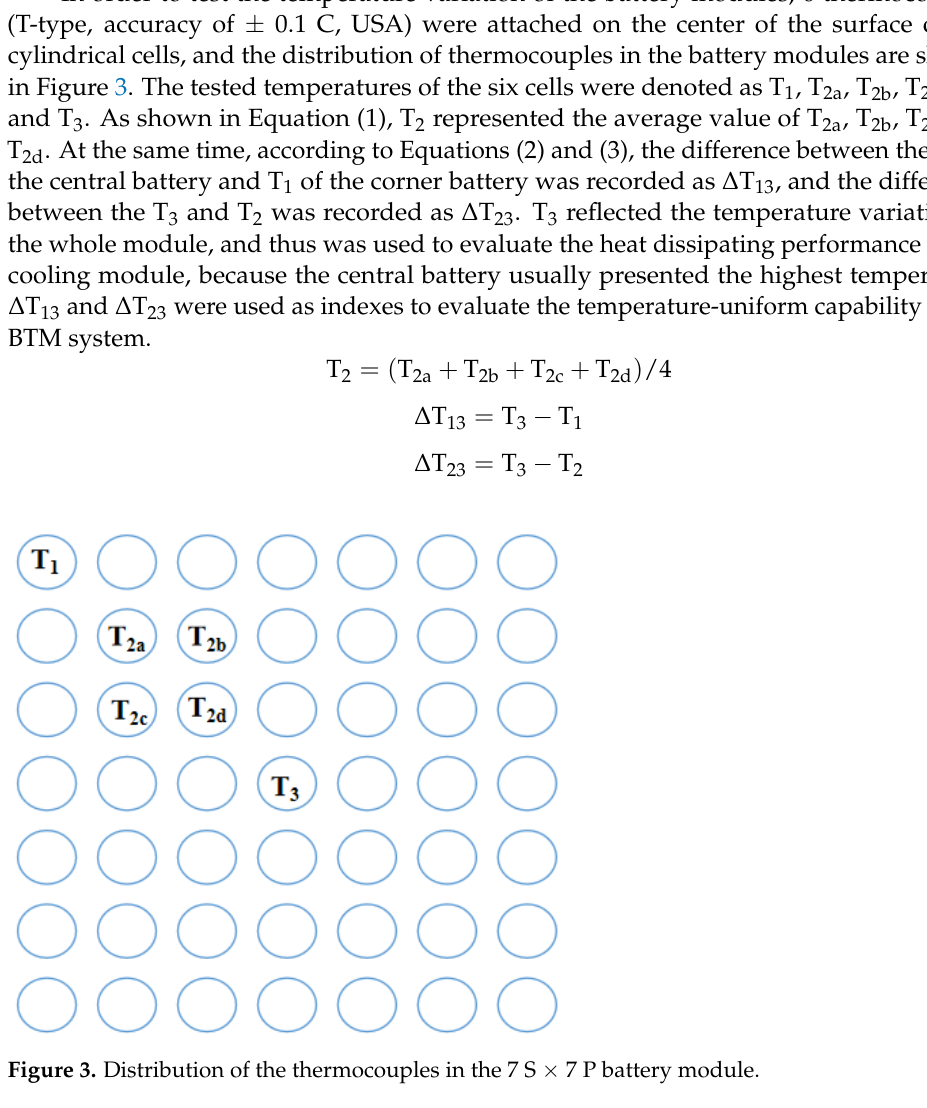
Figure 3. Distribution of the thermocouples in the 7 S × 7 P battery module.